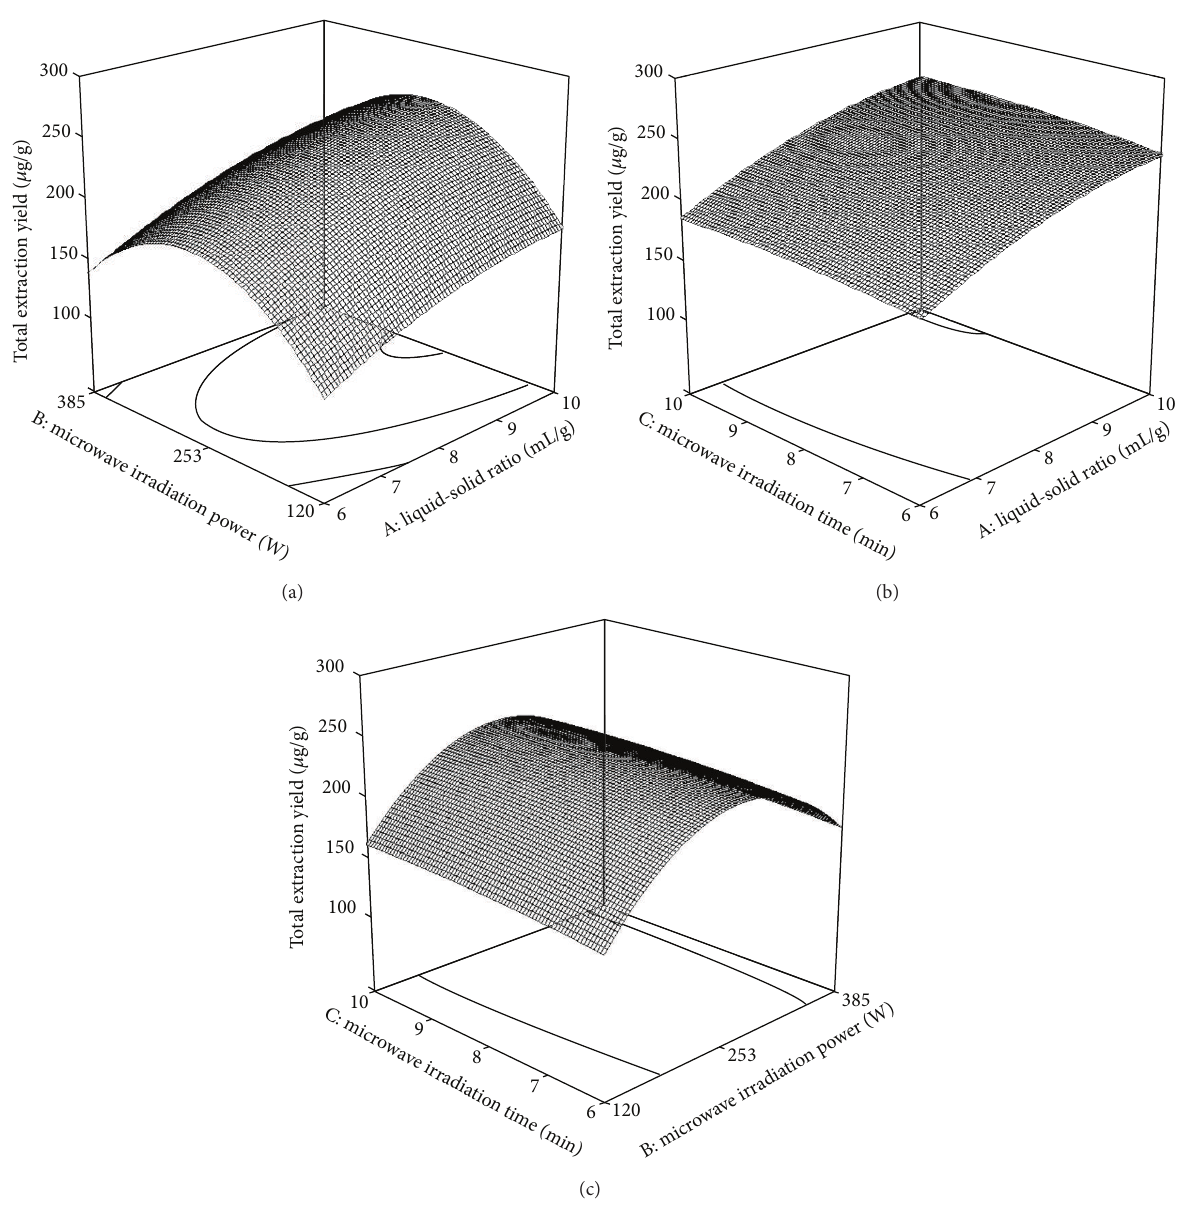
Figure 3: Response surface plots showing the effects of variables on total extraction yield. (a) Interaction of liquid-solid ratio and microwave irradiation power; (b) interaction of liquid-solid ratio and microwave irradiation time; (c) interaction of microwave irradiation power and